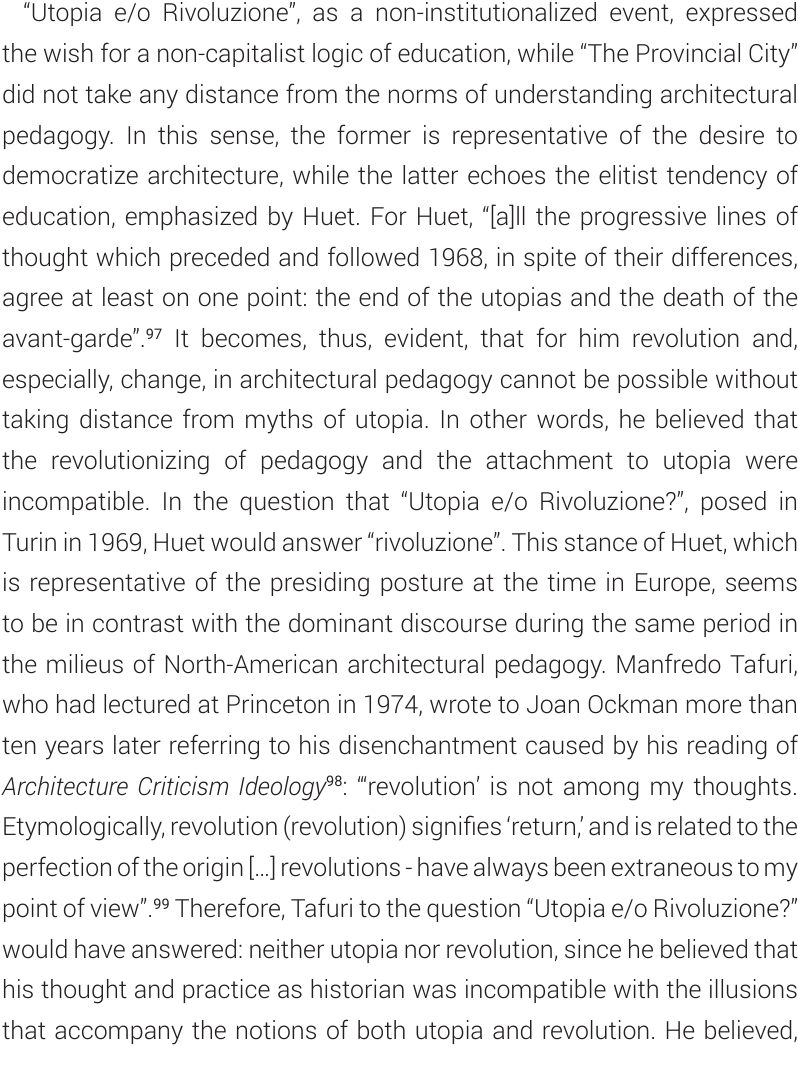
title reflects this perspective, which I tried to explain above, regarding the non-efficiency in terms of social mutations of utopian projects.